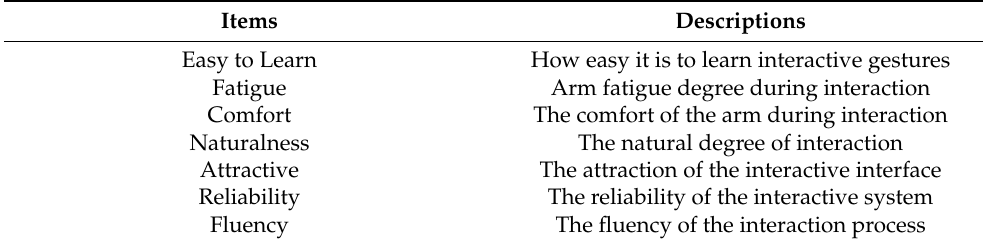
Table 1. Contents of Likert scale. Items